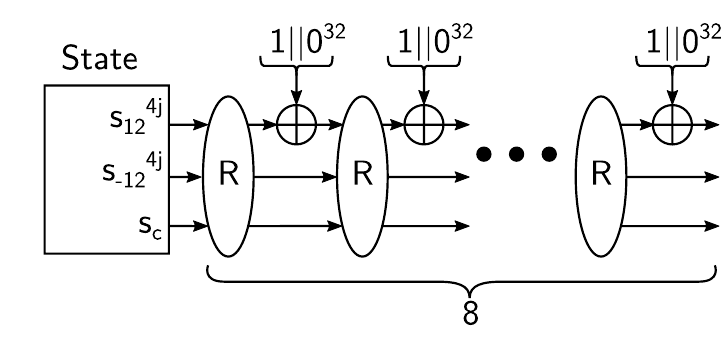
Figure 10: Subterranean blank.